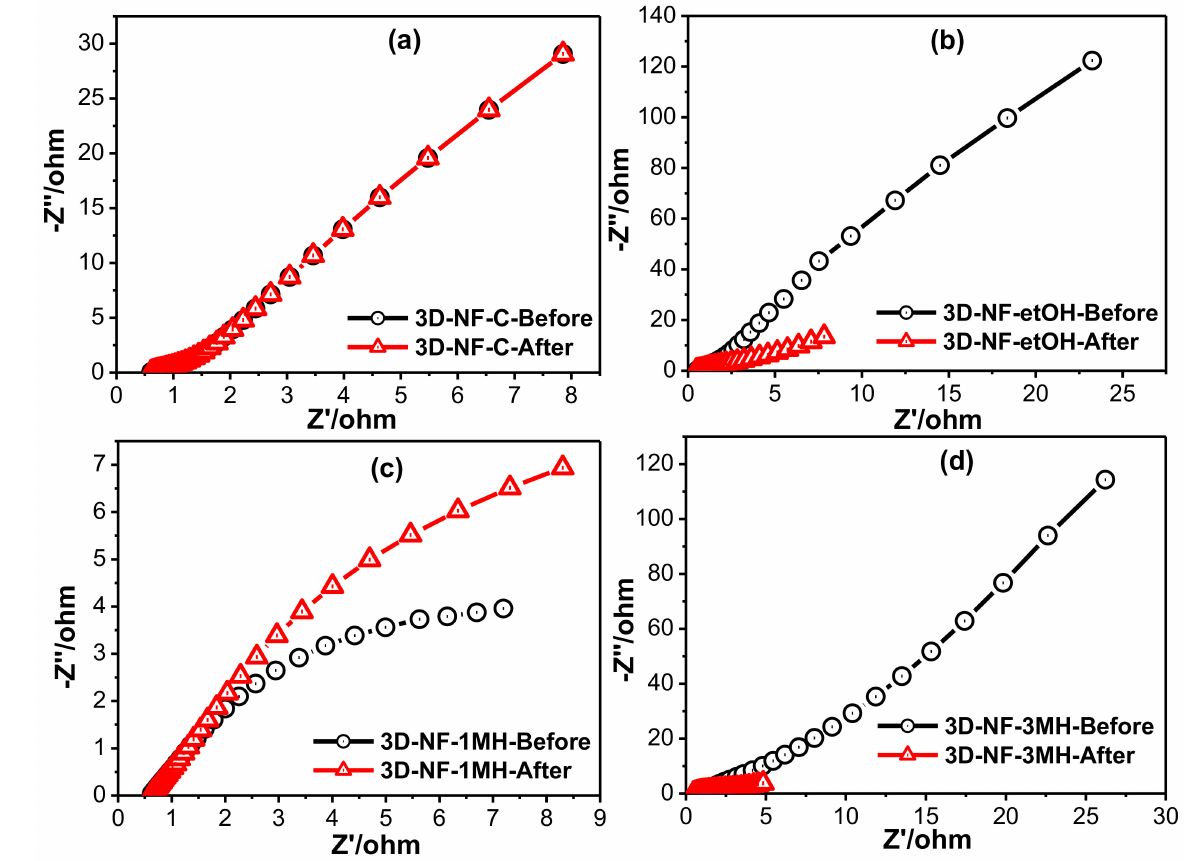
Figure 6. Electrochemical impedance spectra of the ( a ) 3D-NF-C; ( b ) 3D-NF-etOH; ( c ) 3D-NF-1MH; ( d ) 3D-NF-3MH before and after electrochemical